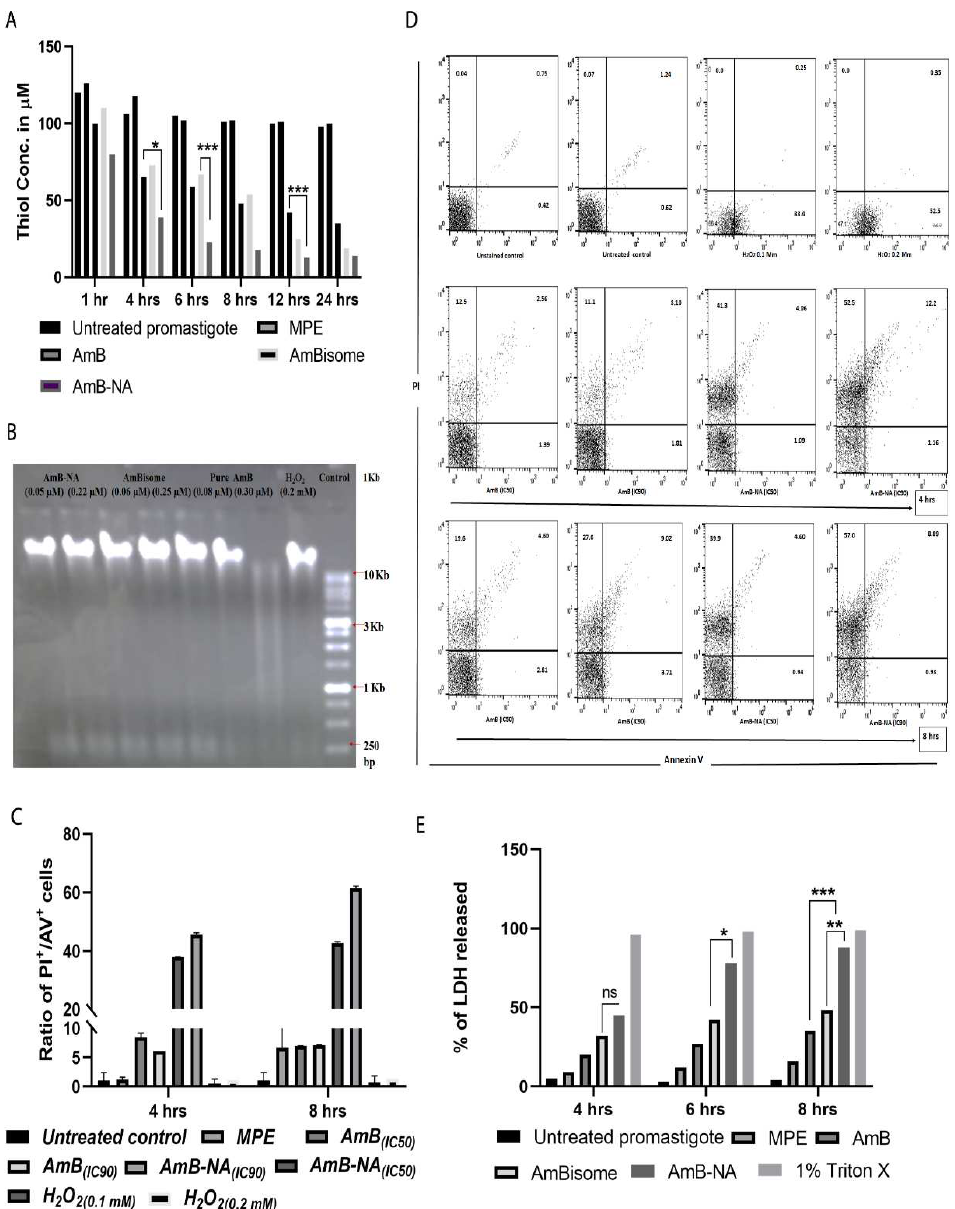
Figure 5. AmB-NA formulation-treated promastigote revealed reduced intracellular thiol and necrotic mode of cell death. ( A ) Effect of nanoparticles-based AmB-NA formulation as a function of the level of thiol derivative DTNB. Total intracellular reduced thiol was measured in deproteinized extracts of metacyclic L . donovani with or without drug formulation at the respective IC 50 value of the drug formulation. After 12 h, AmB-NA (0.5 µM)-treated parasites revealed a ~3.2-fold decline in thiol release compared to AmB-treated parasites ( p < 0.001). ( B ) Agarose (1%) gel electrophoresis of genomic DNA isolated from parasites treated with nanoparticles derived AmB-NA, AmB, AmBisome, and H 2 O 2 with 100 bp and 1 kb DNA ladder as markers. Untreated and H 2 O 2 -treated (0.2 mM)